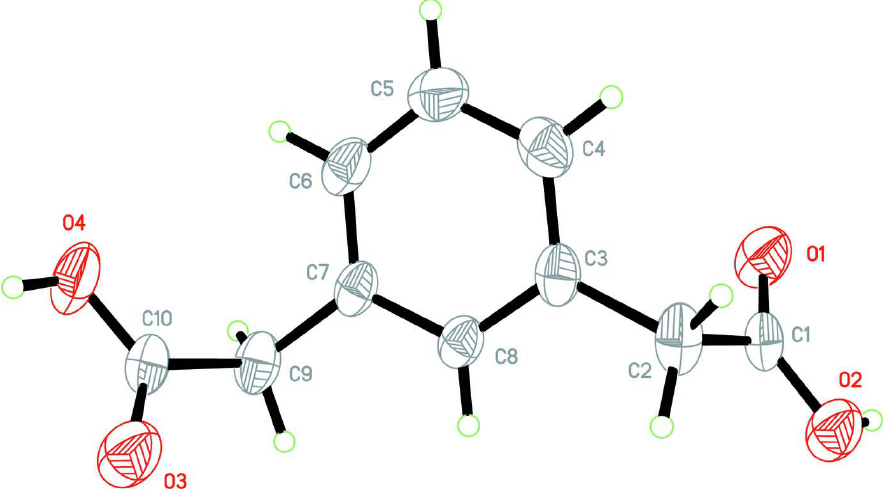
The structure of the title compound with the atomic numbering scheme. Displacement ellipsoids are drawn at the 30% probability